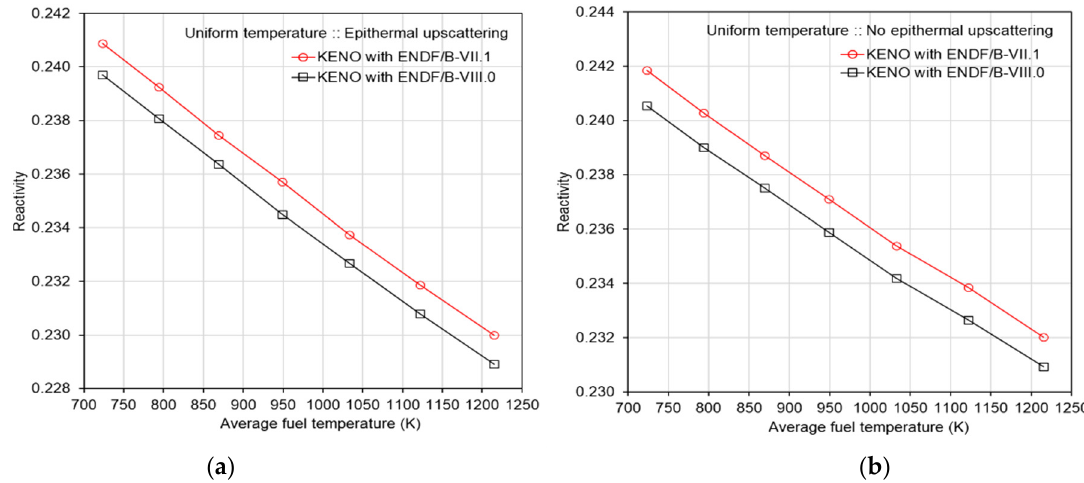
Figure 4. Comparison of reactivities with uniform fuel temperature distribution: ( a ) epithermal upscattering; ( b ) no epithermal upscattering.